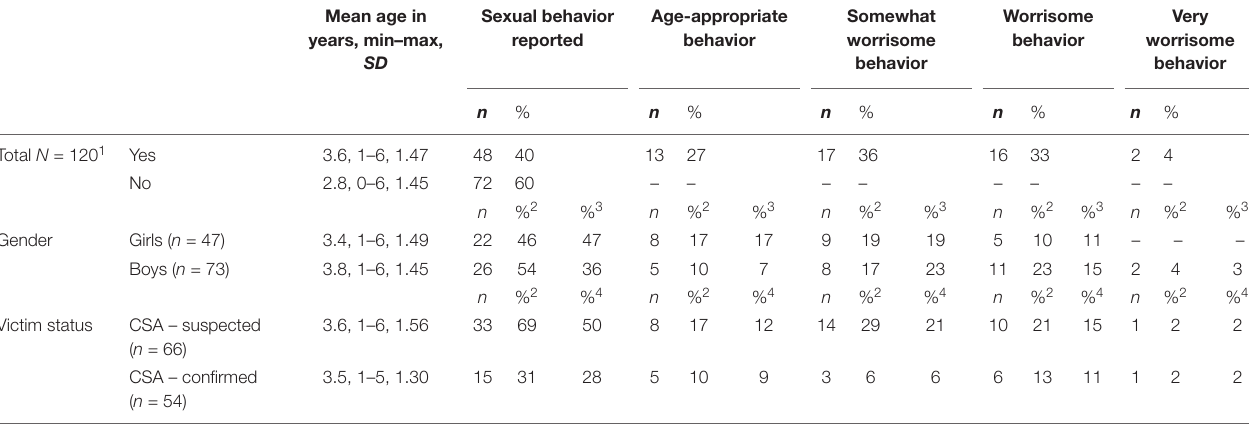
TABLE 4 | Prevalence of sexual behavior reported by